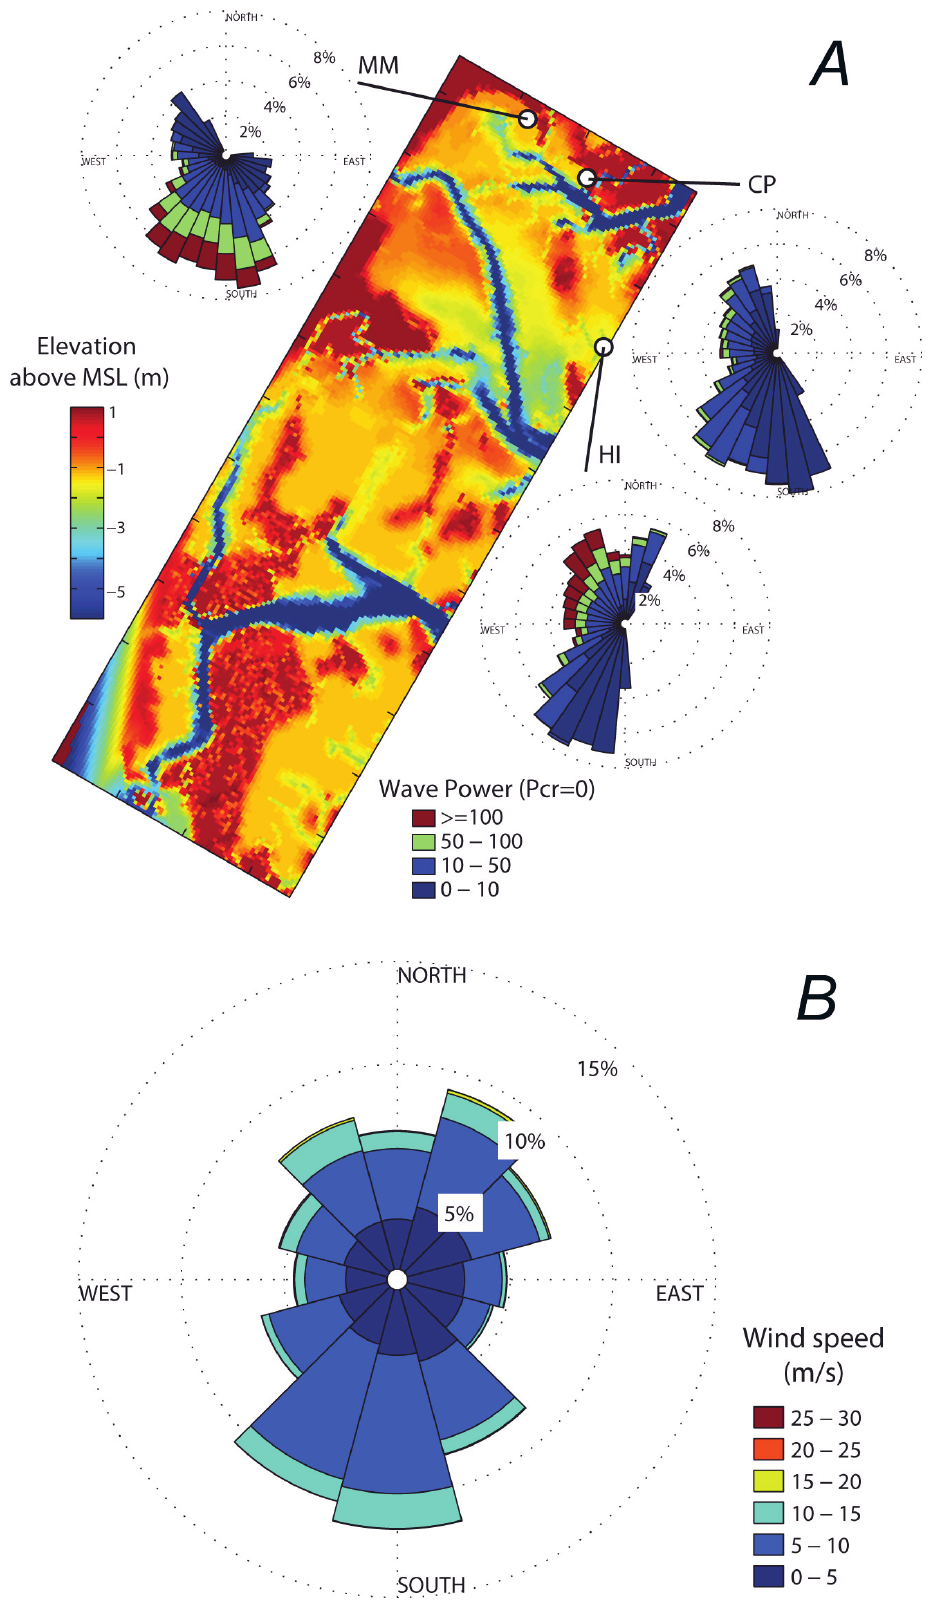
Figure 4. ( A ) Digital elevation model of Hog Island Bay used to hindcast wave height and wave period with the SWAN model. The distribution of wave power (W/m) and directions from the model output is shown for each study location; ( B ) distribution of wind speed (m/s) and directions used to force the